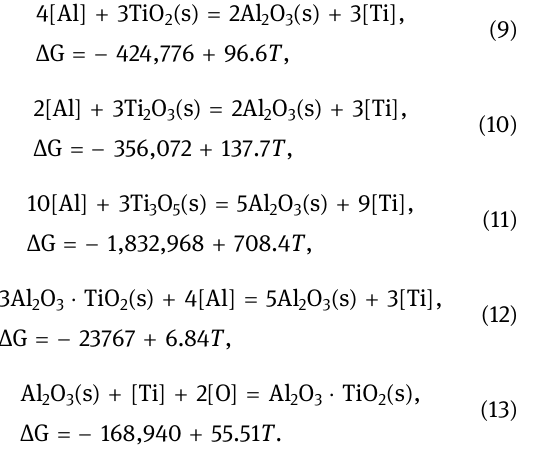
Figure 12: Schematic diagram of the crushing of modi fi